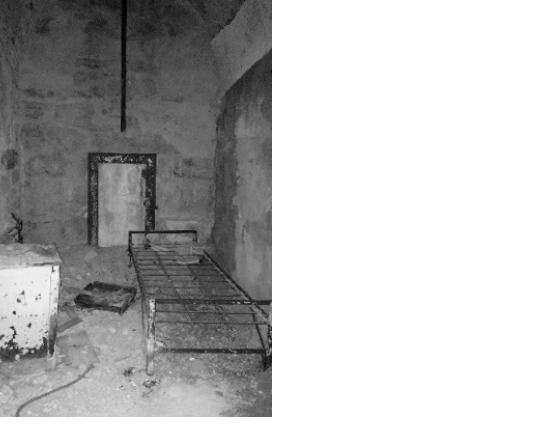
Figure 5. A cell at the Eastern Penitentiary Museum showing rough wall finishes.